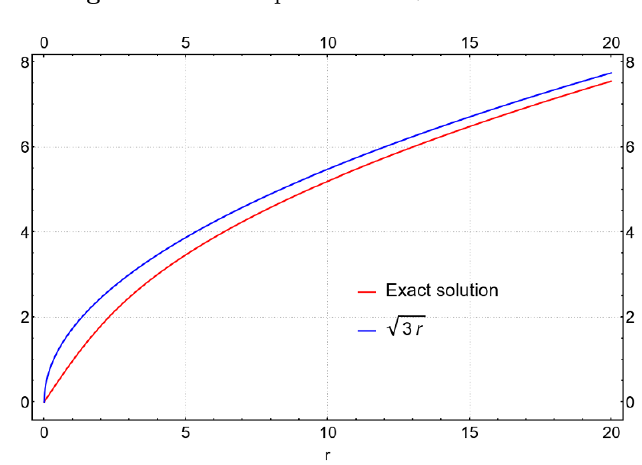
Figure 1 . The warp factors for M = S 3 (cid:2) S 3 .